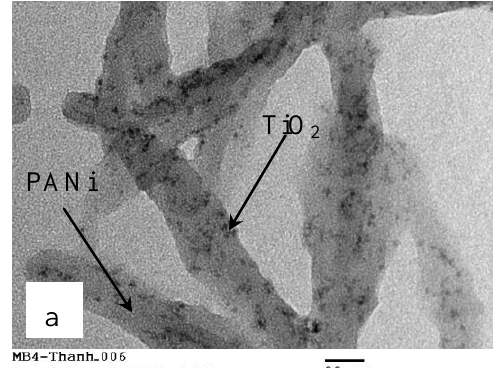
Figure 2. TEM images of TiO